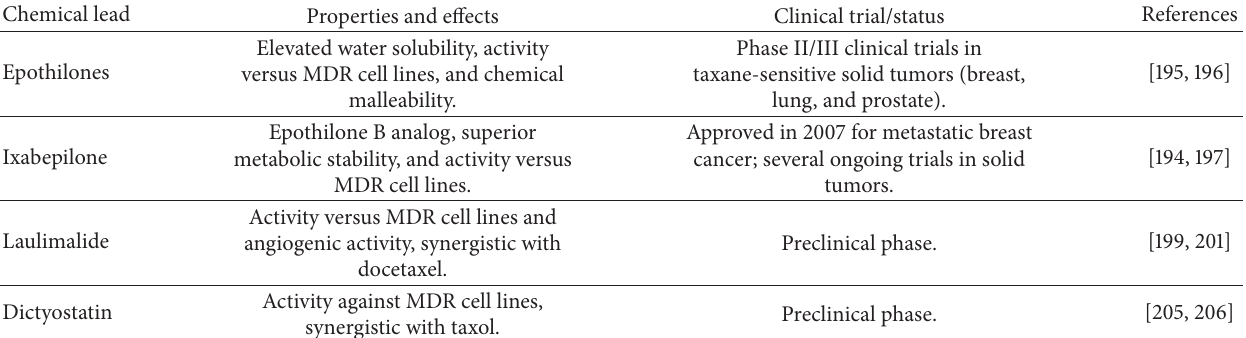
Table 2: Microtube-stabilizing